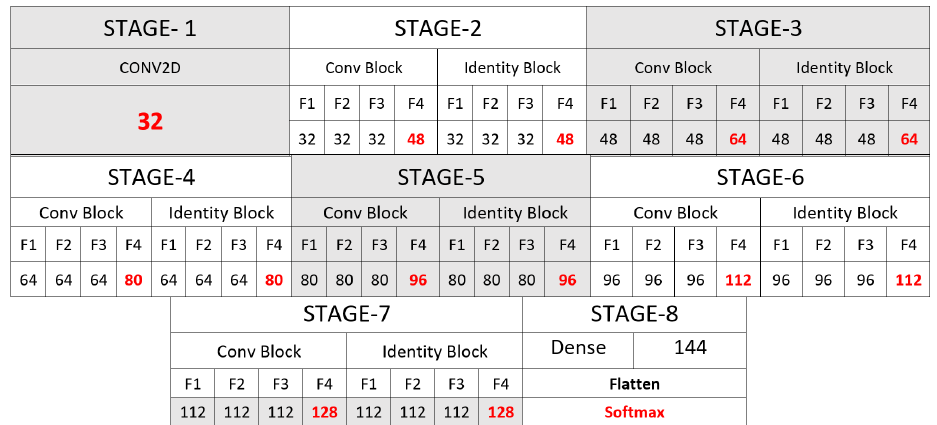
Figure 3. Filter Configuration of LEMON Network. The red values represent the number of filters in the final layer of each